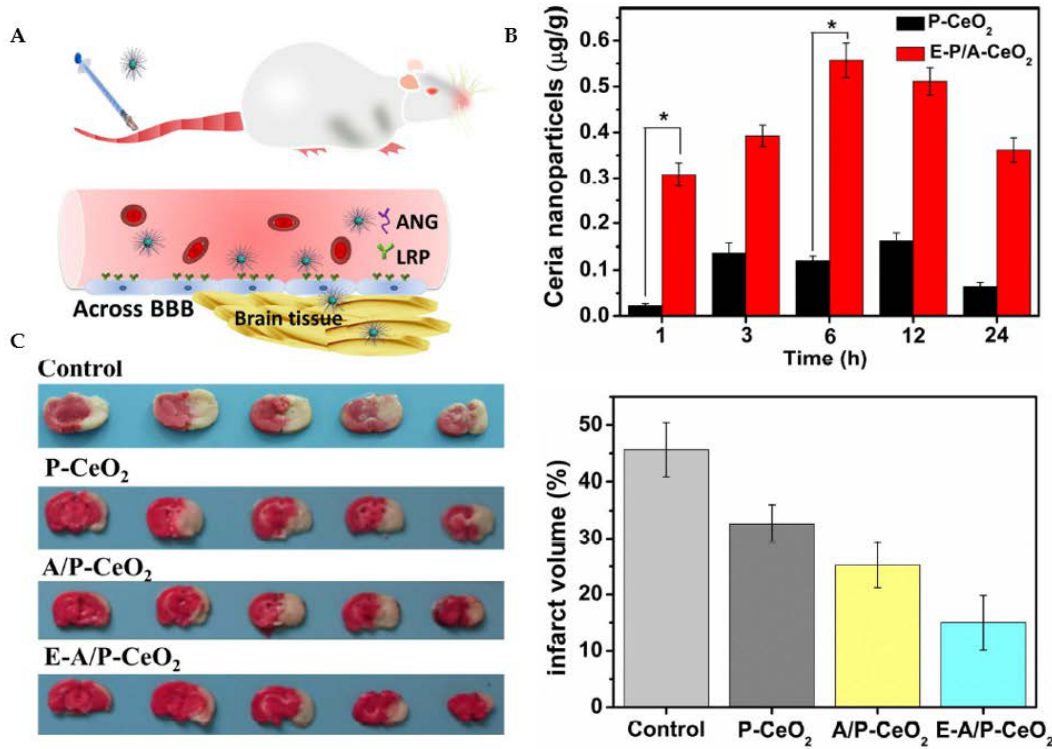
Figure 9. Ceria nanoparticles for neuroprotection against stroke and BBB disruption. E-A/P-CeO 2 and A/P-CeO 2 , ceria nanoparticles loaded with or without edaravone and modified with Angiopep-2 (ANG) and polyethylene glycol (PEG) on their surface; P-CeO 2 , ceria NPs decorated with PEG. ( A ) Schematic representation of the Angiopep-2 (ANG-targeting) of lipoprotein receptor-related peptide (LRP) on the brain capillary endothelial cells (BCECs) that promote E-A/P-CeO 2 crossing the BBB into brain tissue for the treatment of stroke. ( B ) Cerebral uptake of ceria nanoparticles was conducted on healthy rats whose BBB was complete. ICP-OES was used to measure the concentrations of ceria nanoparticles in brain tissue following intravenous injection. E-A/P-CeO 2 nanoparticles were successfully carried across the BBB into the brain by an ANG-targeting and LRP-receptor-driven transcytosis mechanism in vivo. The results in Panel B demonstrate the accumulation of ceria NPs in the brain region within 24 h compared with P-CeO 2 (* p < 0.05). ( C ) A model of stroke, middle cerebral artery occlusion (MCAO), was injected with different concentrations of ceria nanoparticles. Cerebral infarct volume was measured after 24 h by triphenyl tetrazolium chloride (TTC) staining. The normal stained tissue is red, and the unstained infarction is white. The result shows a high infarct volume of the control group of saline injection by 45.6 ± 4.8%. In contrast, treatment with E-A/P-CeO 2 caused a decrease in infarction up to 15.0 ± 4.1% at an optimal concentration of 0.6 mg/kg in a dose-dependent manner. The neuroprotective effect of ceria nanoparticles indicates that E-A/P-CeO 2 is more potent than A/P-CeO 2 and P-CeO 2 , suggesting that edaravone attenuates ROS scavenging coupled with a targeted effect, thanks to the ceria core system which enhanced the antioxidant potency for improved treatment in vivo. Adapted with permission from [112]. Copyright {2018} American Chemical